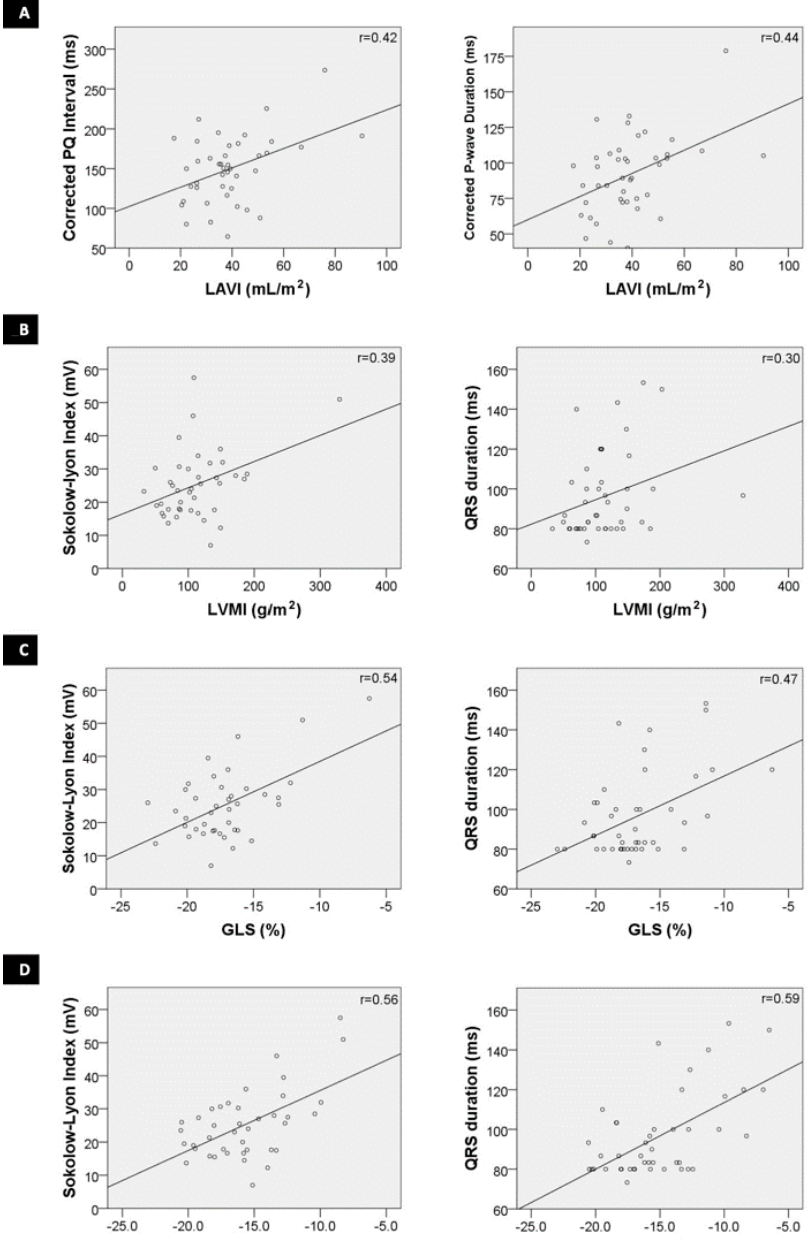
Figure 2. Correlation between electrocardiographic and echocardiographic parameters; ( A )— Correlation between corrected PQ interval and maximum left atrial volume indexed to body surface area (LAVI) and between corrected P-wave duration and LAVI; ( B )—Correlation between Sokolow– Lyon index and left ventricular mass indexed to body surface area (LVMI) and between QRS duration and LVMI; ( C )—Correlation between Sokolow–Lyon index and Global Longitudinal Strain (GLS) and between QRS duration and GLS; and ( D )—correlation between Sokolow–Lyon index and Basal Longitudinal Strain (LS) and between QRS duration and Basal